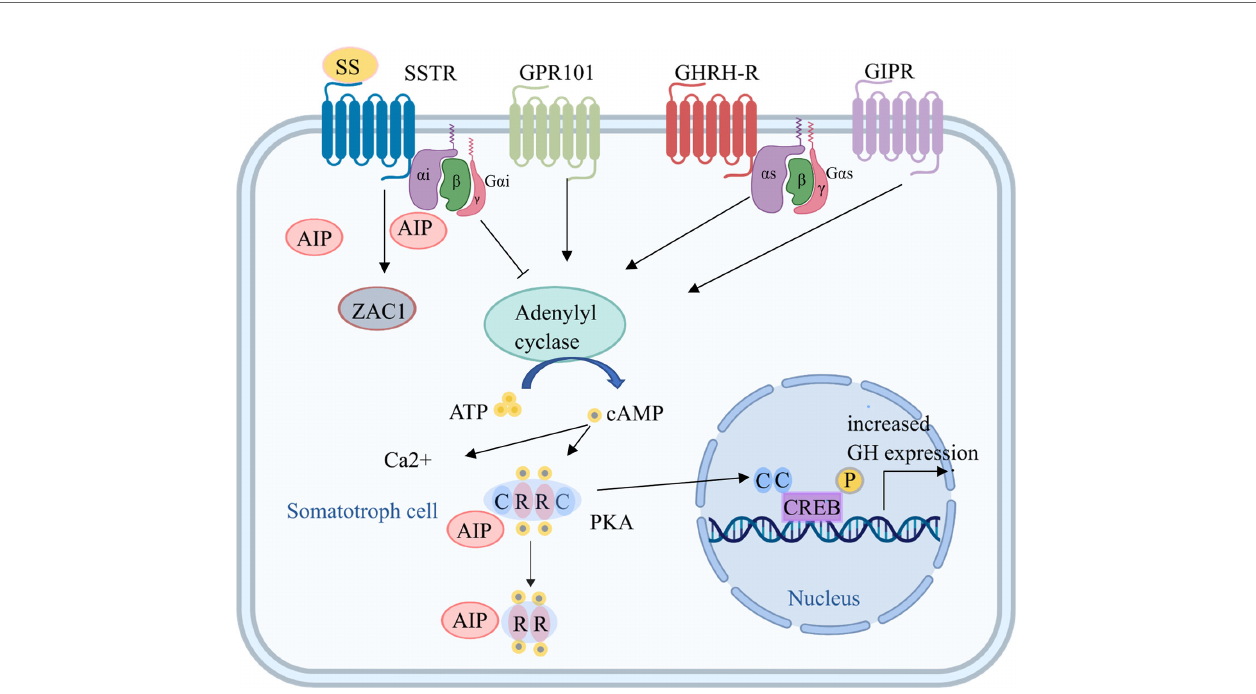
FIGURE 1 | Tumorigenic mechanisms in somatotroph cells. Several mechanisms increase cAMP production, which is key for somatotroph tumorigenesis. Hormones bind to receptors, including GHRH-R, SSTR, GPR101, and GIPR, on the somatotroph cell membrane and increase the activation of adenylyl cyclase through Gs a . The consequent increase in cAMP production leads to the dissociation of the regulatory subunits of PKA from the catalytic subunits, which then translocate to phosphorylate CREB in the nucleus and other targets, leading to increased GH expression and cell proliferation. Gs a activation induced by GNAS mutations also leads to upregulation of the cAMP pathway. In addition, ectopic expression of GIPR may lead to an activated cAMP pathway, and GPR101 is a Gs a - coupled constitutively active receptor that leads to increased cAMP signaling. AIP, aryl hydrocarbon receptor-interacting protein; ATP, adenosine triphosphate; C, catalytic subunit; cAMP, cyclic adenosine monophosphate; CREB, cAMP response element; GHRH, growth hormone-releasing hormone; GHRH-R, GHRH receptor; GIPR, gastric inhibitory polypeptide receptor; GPR101, G protein-coupled receptor 101; Gs a , G protein stimulatory alpha subunit; GTP, guanine triphosphate; PKA, protein kinase A; R, regulatory subunit; SSTR, somatostatin receptor; ZAC1, zinc fi nger protein PLAGL1.